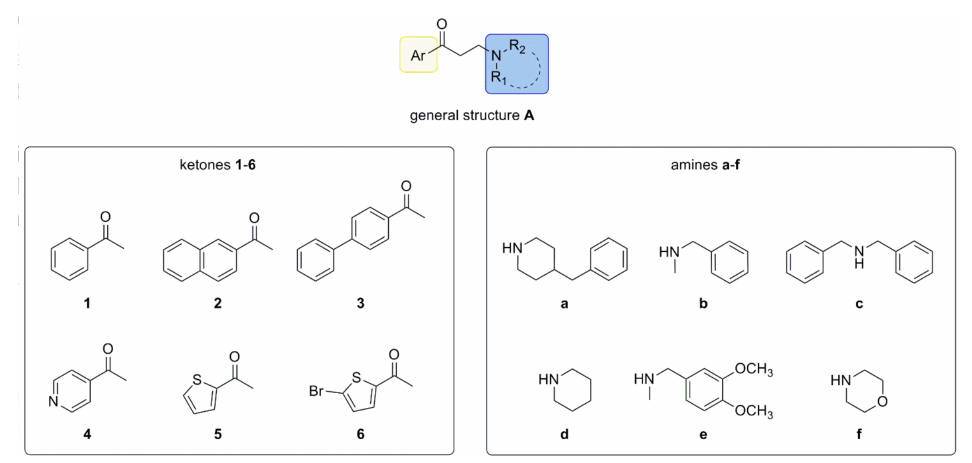
Figure 3. Designed